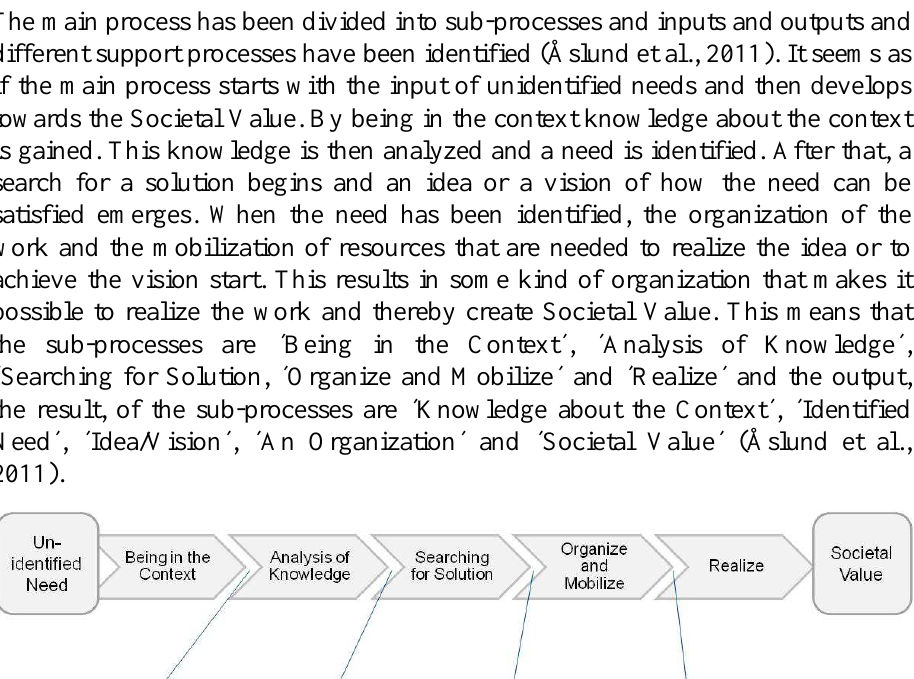
Figure 1 – The proposed model of the societal entrepreneurship processes (after Åslund, Bäckström and Wiklund,